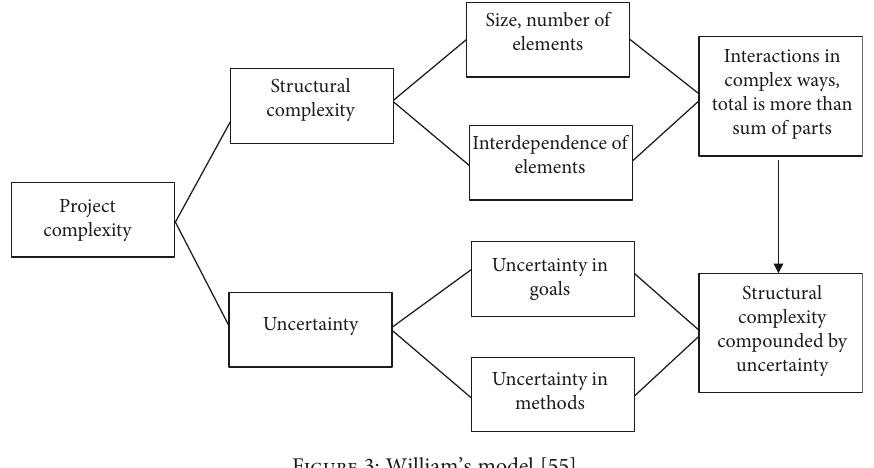
Figure 3: William ’ s model [55]. Table 2: Context ’ s characteristics, leader ’ s job, danger signals, and response to danger